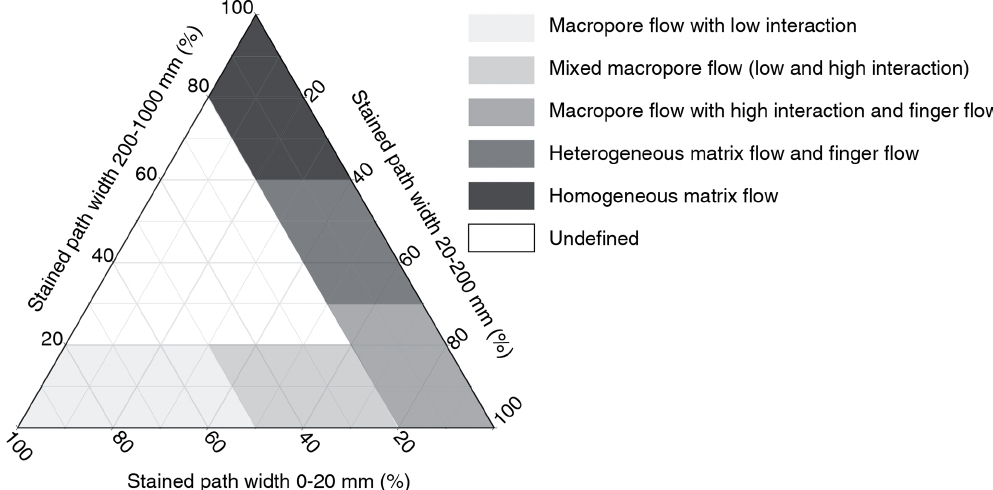
Figure 4. Ternary diagram for flow type classification based on the proportion of the three stained path width classes (after Weiler,